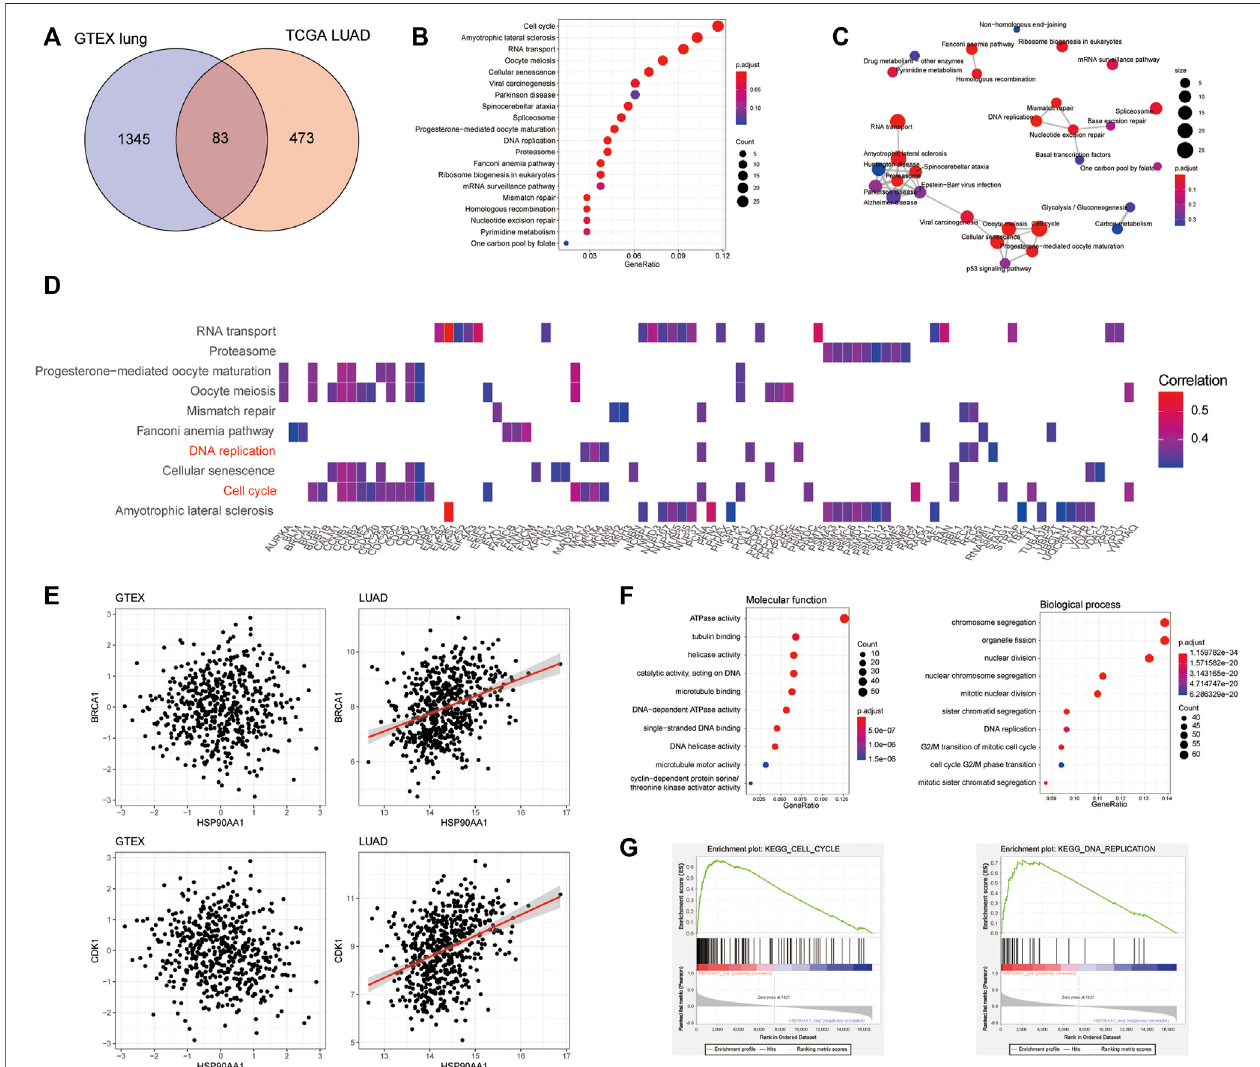
FIGURE 2 | The transcription pro fi le of HSP90AA1 correlated genes was different between lung cancer and normal tissues. (A) The Venn plot indicated the overlappinganddifferencesofthegenespositivelycorrelatedwithHSP90AA1expressioninnormal(GTEX)andcancerous(TCGALUAD)lungs. (B & C) Enrichmentand correlationsofHSP90 positively correlated genesin KEGG pathways. (D) Theheatmap ofindicated genesenriched inthe correspondingpathways and theircorrelation with HSP90AA1 expression. (E) The correlation of BRCA1 and CDK1 with HSP90AA1 in the GTEX and TCGA databases. (F) The enrichment of GO terms of molecular function and biological process in HSP90AA1 correlated genes. (G) GSEA analysis of HSP90AA1 indicated the possible correlated genes enriched in KEGG pathways of cell cycle and DNA replication.